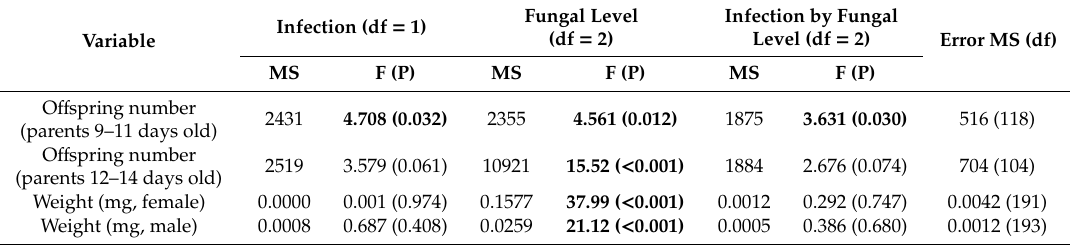
Table 2. ANOVAs (MS = mean square, F ratio, probability) for o ff spring number and o ff spring